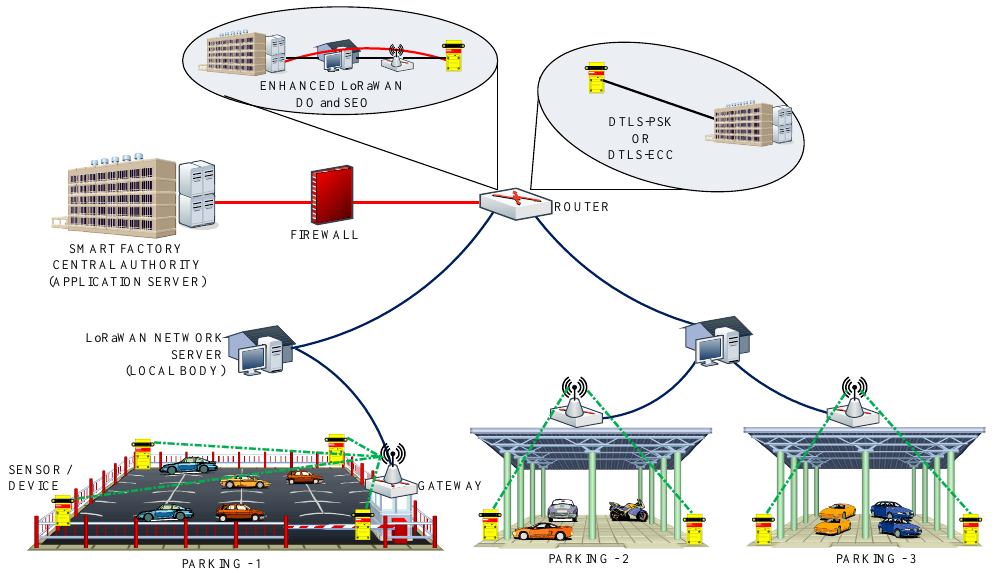
Figure 15. An illustration of the case study of protocols for a smart factory-enabled parking system.